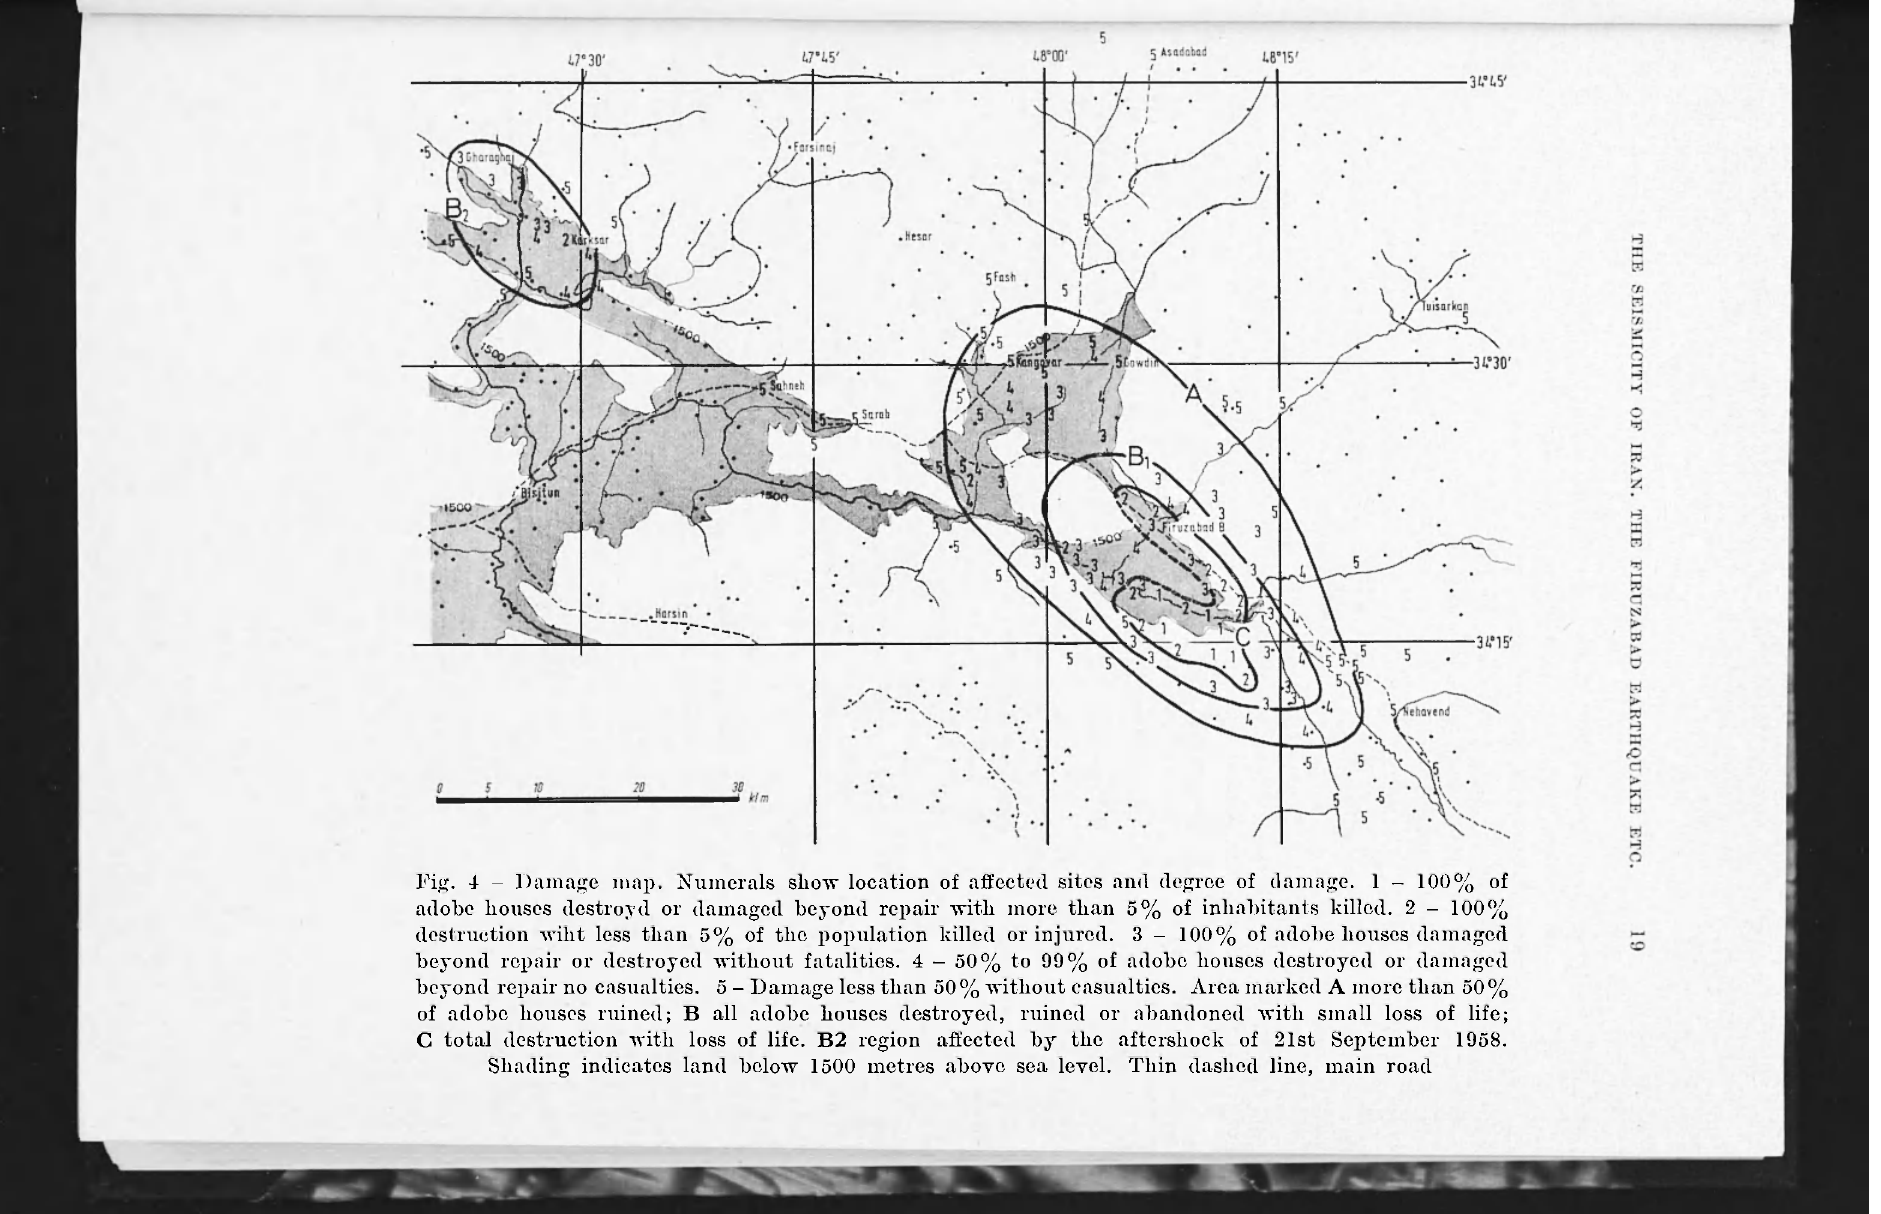
Fig. 4 - Damage map. Numerals show location of affected sites and degree of damage. 1 - 100% of adobe houses destroyd or damaged beyond repair with more than 5% of inhabitants killed. 2 - 100% destruction wiht less than 5% of the population killed or injured. 3 - 100% of adobe houses damaged beyond repair or destroyed without fatalities. 4 - 50% to 99% of adobe houses destroyed or damaged beyond repair no casualties. 5 - Damage less than 50% without casualties. Area marked A more than 50% of adobe houses ruined; B all adobe houses destroyed, ruined or abandoned with small loss of life; C total destruction with loss of life. B2 region affected by the aftershock of 21st September 1958. Shading indicates land below 1500 metres above sea level. Thin dashed line, main